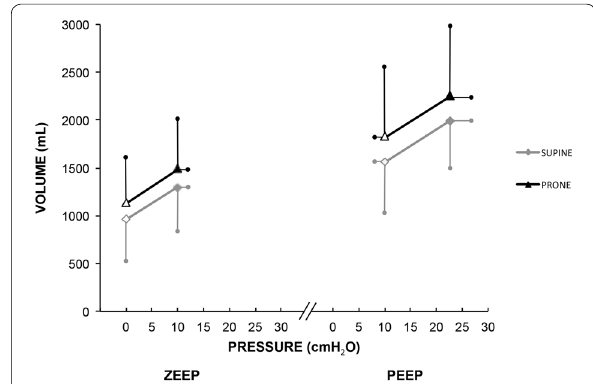
Fig. 3 Variation in lung volumes in supine and prone positions. Clear triangles and clear rhombus are the resting lung volumes at ZEEP and at PEEP. Dark triangles and dark rhombus represent end‑inspiratory lung volumes and end‑inspiratory lung pressure (Pplat) at ZEEP and